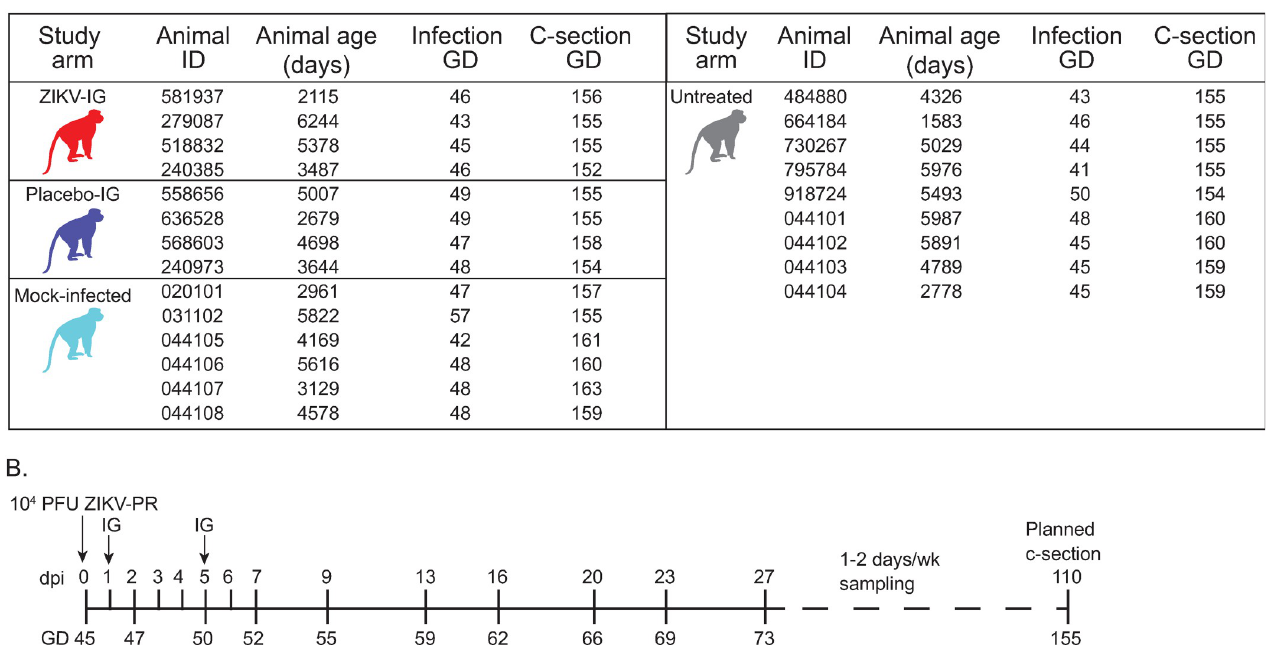
Fig 1. Animal demographics and study timeline. ( A ) Animal ID, animal age at the time of ZIKV or mock inoculation, gestational day (GD) at the time of infection, and gestational day at the time of cesarean section (C-section). Each study arm is represented in subsequent graphs by the color shown in the monkey for each group. ( B ) Timeline representing the day of inoculation, treatment, blood sampling (ticks on the line), and C-section for animals in this study relative to either days post-inoculation (dpi) or gestational day (GD). Blood sampling occurred as shown through 27 dpi and then was twice weekly until two consecutive time points were negative for ZIKV RNA and then sampling was once